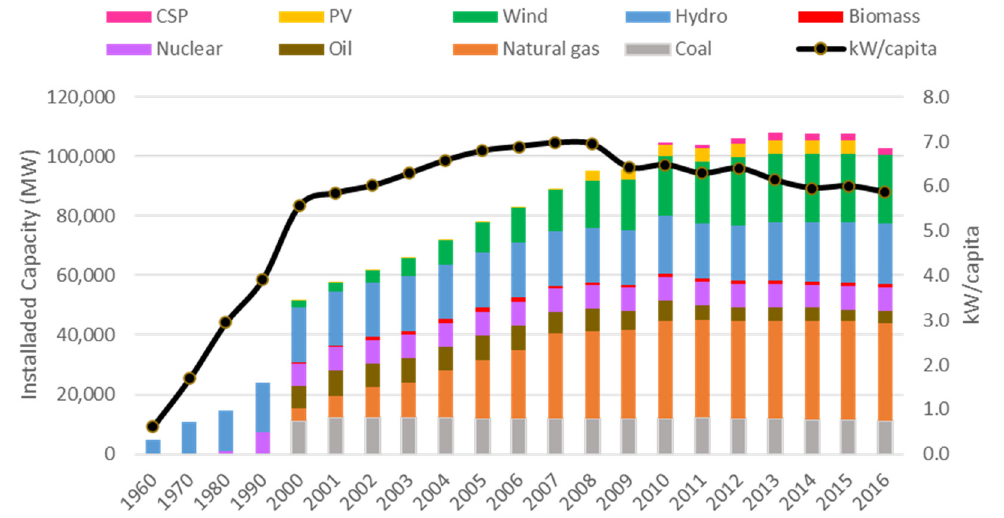
Figure 3. Historic data for installed generation capacity in Spain (2000–2016).